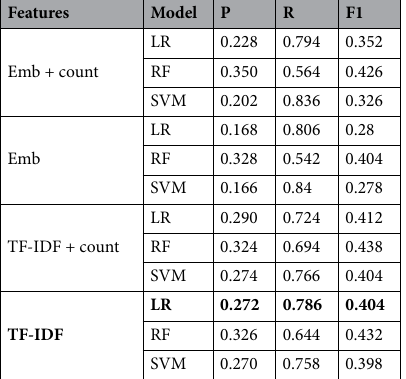
Table 1. Paragraph classification results. P precision, R recall, F1 F1-score for different classification algorithms: LR logistic regression, RF random forests, SVM support vector